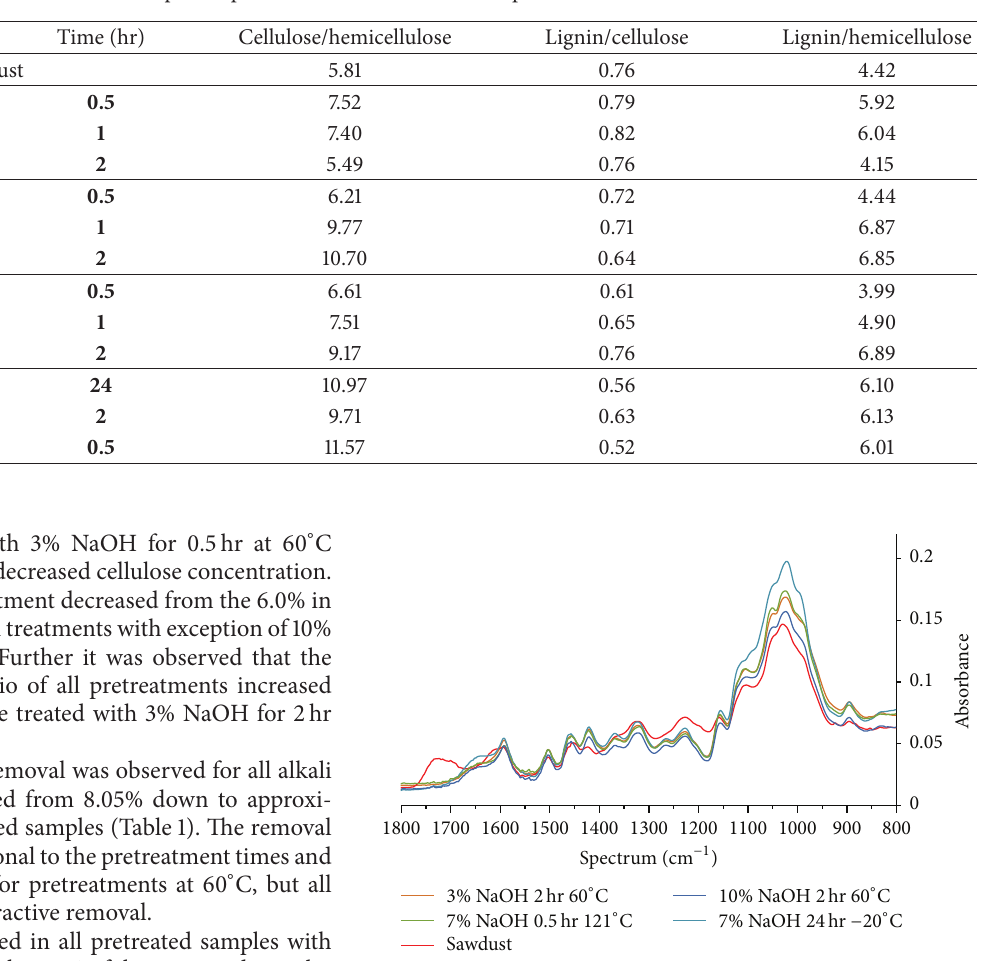
Table 2: Impact of pretreatment on structural composition ratios.